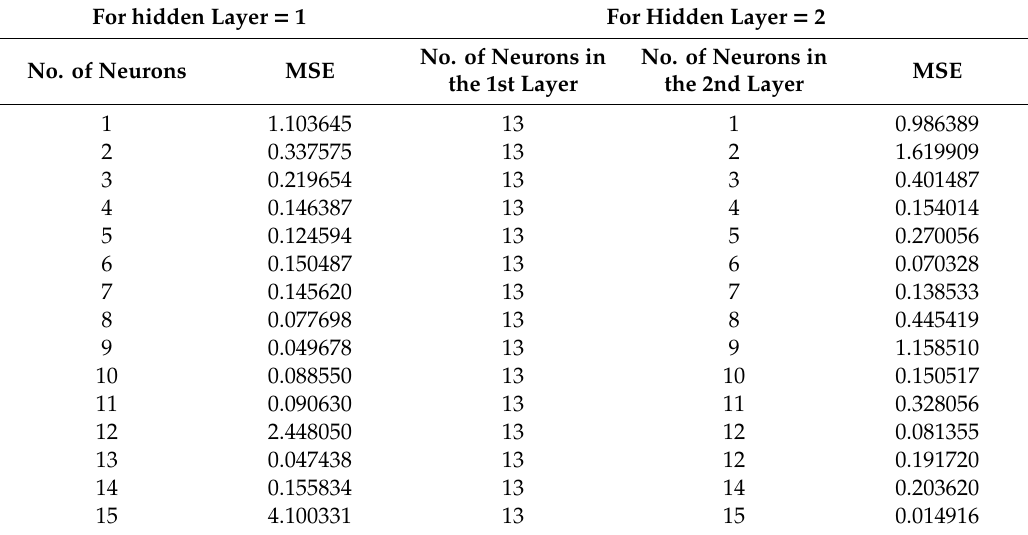
Table 8. ANN architecture performance while varying the number of neurons. For hidden Layer = 1 For Hidden Layer =